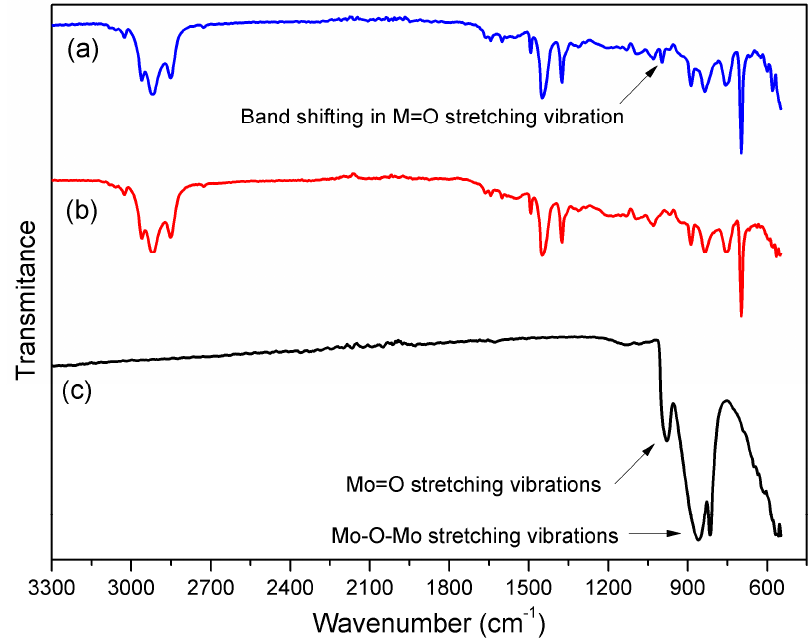
Figure 3. FTIR spectra of MoO 3 / PPy / SIS blends: ( a ) MoO 3 / PPy / SIS blends; ( b ) 15 w / w % PPy / SIS blend; ( c ) Pure MoO 3 nanobelts.